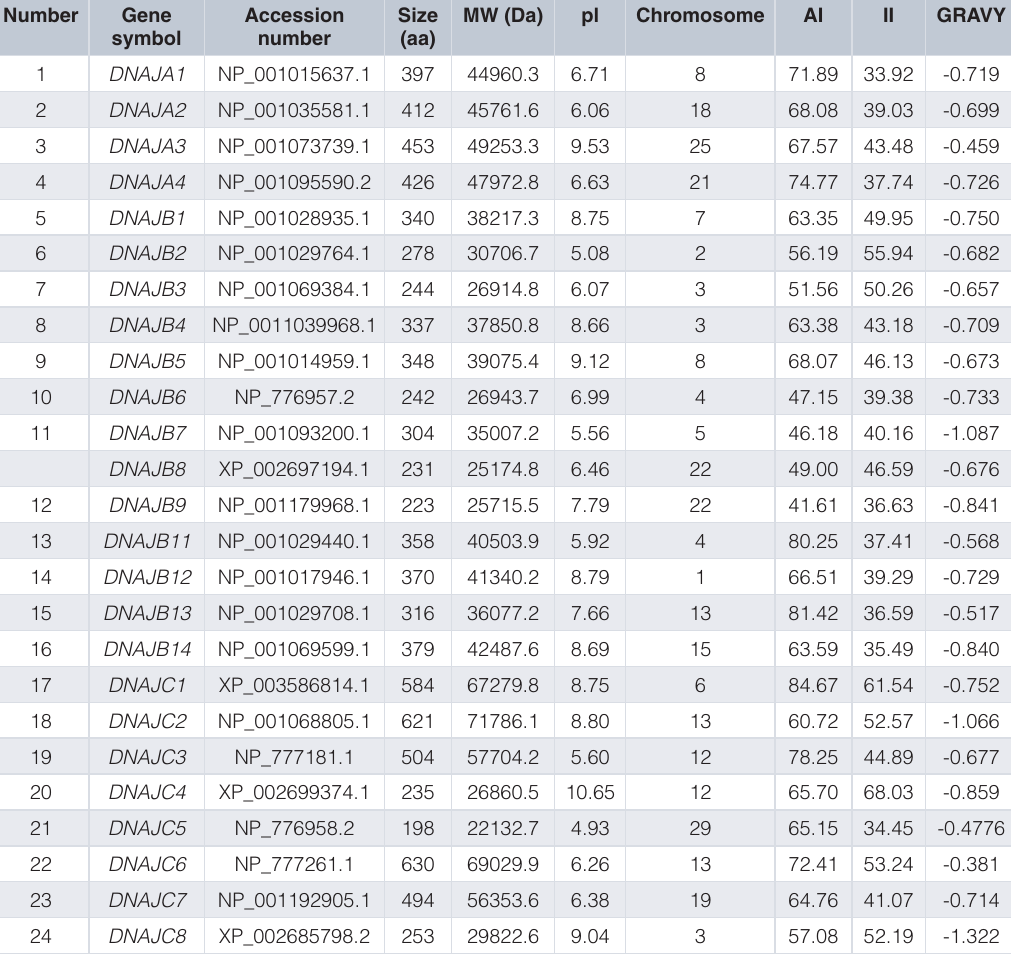
Table 2. Biochemical characterization of the bovine heat shock protein 40 protein